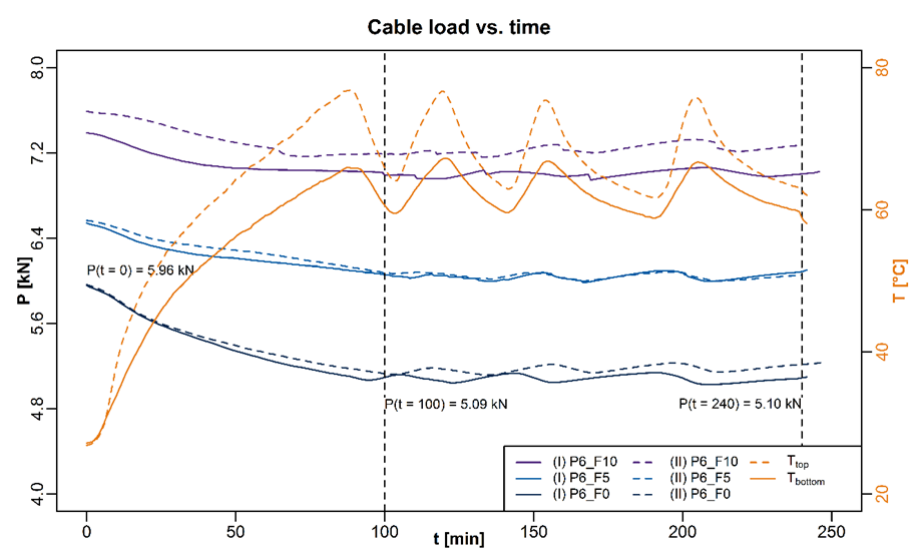
Fig. 9 Change in cable load, specimens (I) and (II) at an initial cable load of P 0 = 6 kN. Temperature for specimen (I)